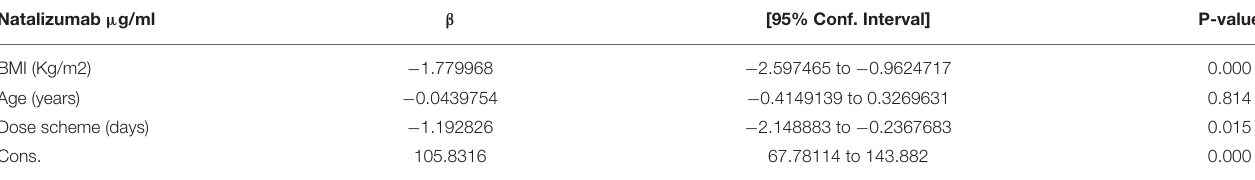
TABLE 3 | Multivariate analysis for drug serum levels and BMI (variables are considered as continuous). Natalizumab µ